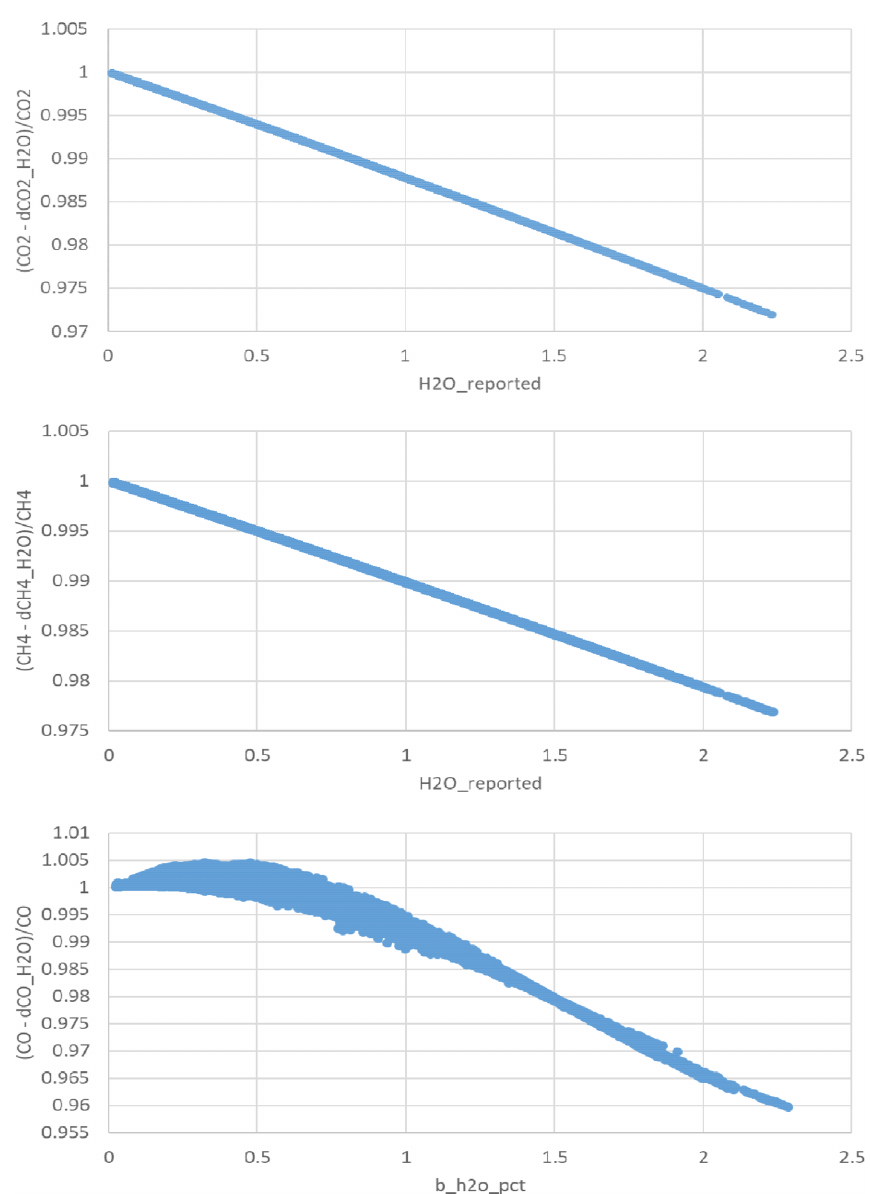
Figure 13. Indirect plots of the H 2 O corrections applied to CO 2 (d CO2_H2O ), CH 4 (d CH4_H2O ) and CO (d CO_H2O ) in physical units for ambient air measurements at IZO, e.g., d CO2_H2O is equal to ( CO2ovc_dry – CO2ovc_wet ) divided by the local slope of the calibration curve (Eq.